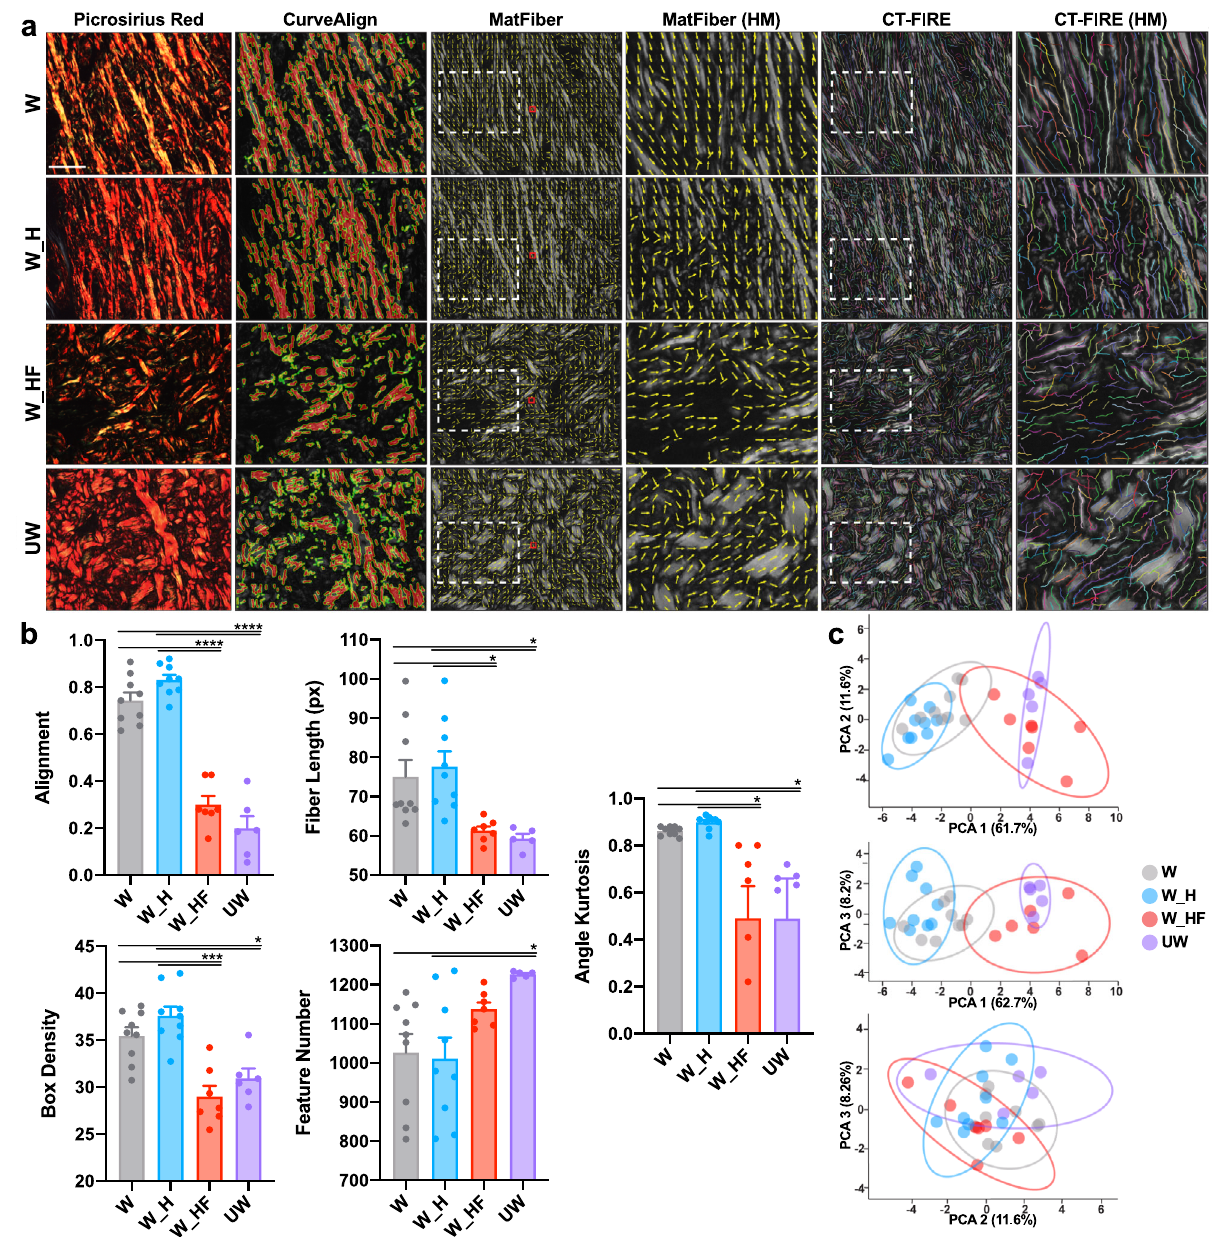
Fig. 2 FAKI-mediated inhibition of mechanotransduction in wounds of large organisms promotes a regenerative organization of collagen fi ber networks. a Picrosirius Red staining of postoperative day 90 standard wounds (W, gray, n = 9 independent wounds), blank pullulan-collagen hydrogels treated wounds (W_H, blue, n = 9 independent wounds), or FAKI-releasing hydrogel treated wounds (W_HF, red, n = 7 independent wounds) was quanti fi ed and compared to unwounded skin (UW, purple, n = 6 independent skin samples) using alignment (CurveAlign, second column), fi ber length metrics (MatFiber, middle two columns), and CT-Fire (right two columns). Scale bar: 10 µ m. b Quanti fi cation of the different collagen fi ber network characteristics, alignment (**** p = 0.0001), fi ber length (* p = 0.0494), box density (*** p = 0.0006 ; * p = 0.0275), feature number (* p = 0.0196), and angle kurtosis (* p = 0.0394) across the four different groups. c Principal component analysis (PCA) plots showing the variance explained by the fi rst three principal components (PCs); PC1 explains 61.7% of the variance, PC2 explains 11.6%, and PC3 explains 8.2%. Statistical comparisons were made using a one-way analysis of variance (ANOVA) with Tukey ’ s multiple comparisons tests. Each datapoint represents an independent wound. All data represent mean ± SEM. Representative images are shown from similar images across all